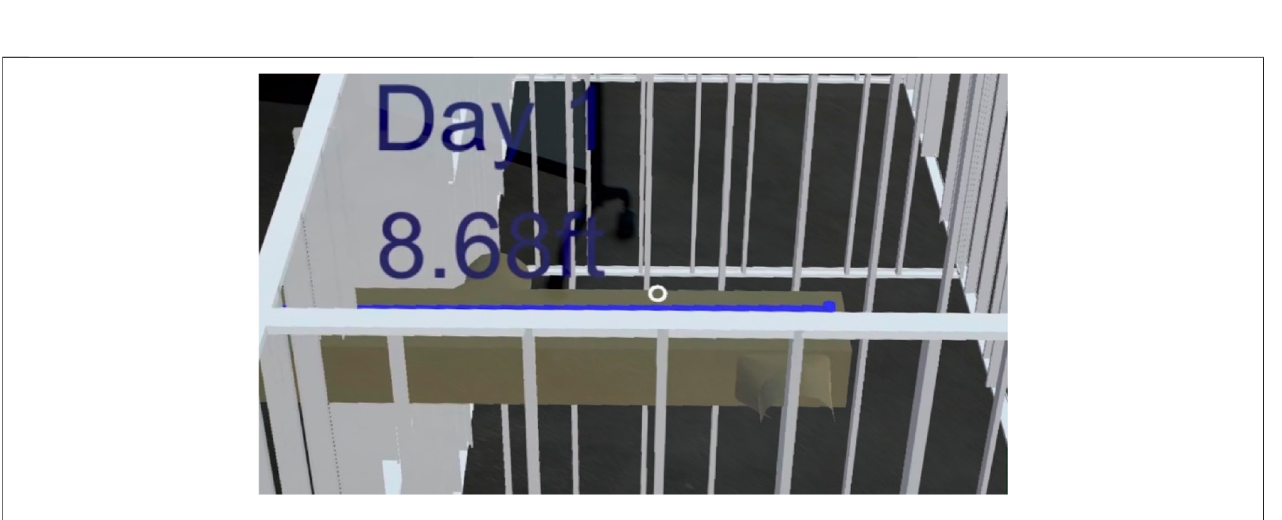
FIGURE 4 | Quantity takeoff of a daily production — day 1.